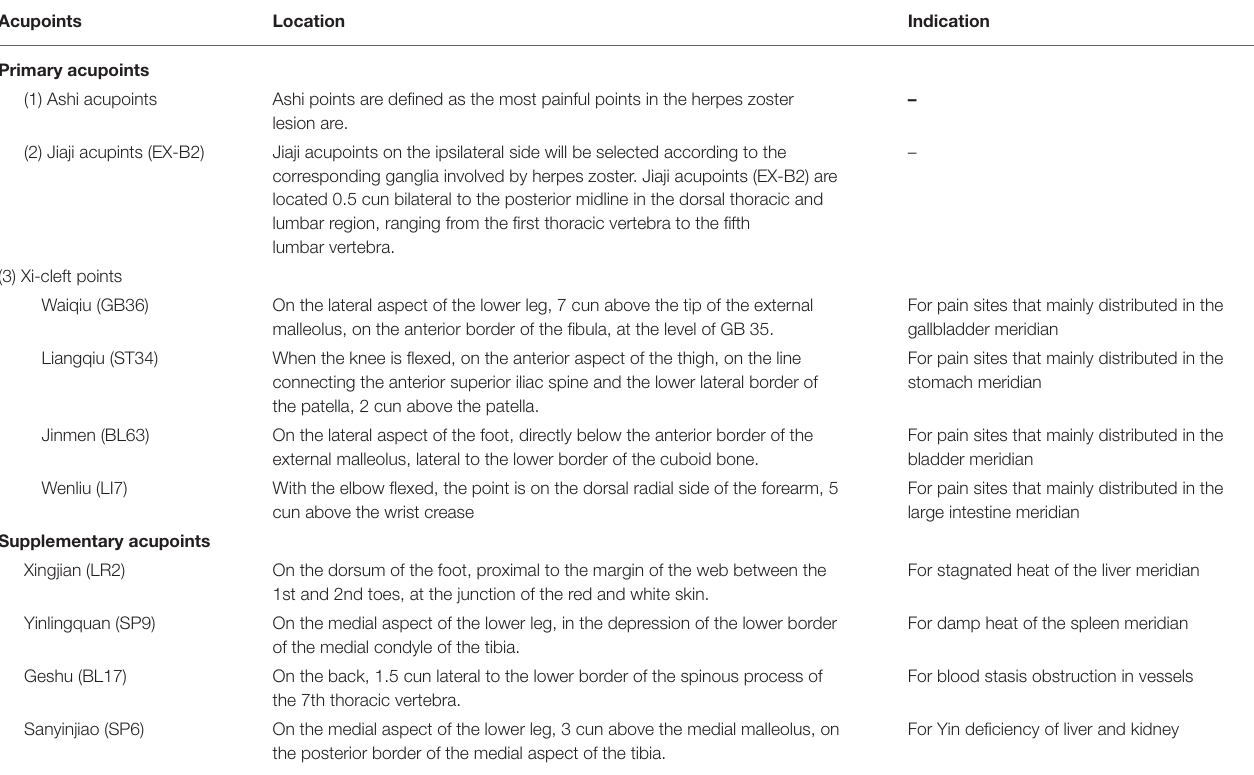
TABLE 3 | Location and indication of acupoints for treating